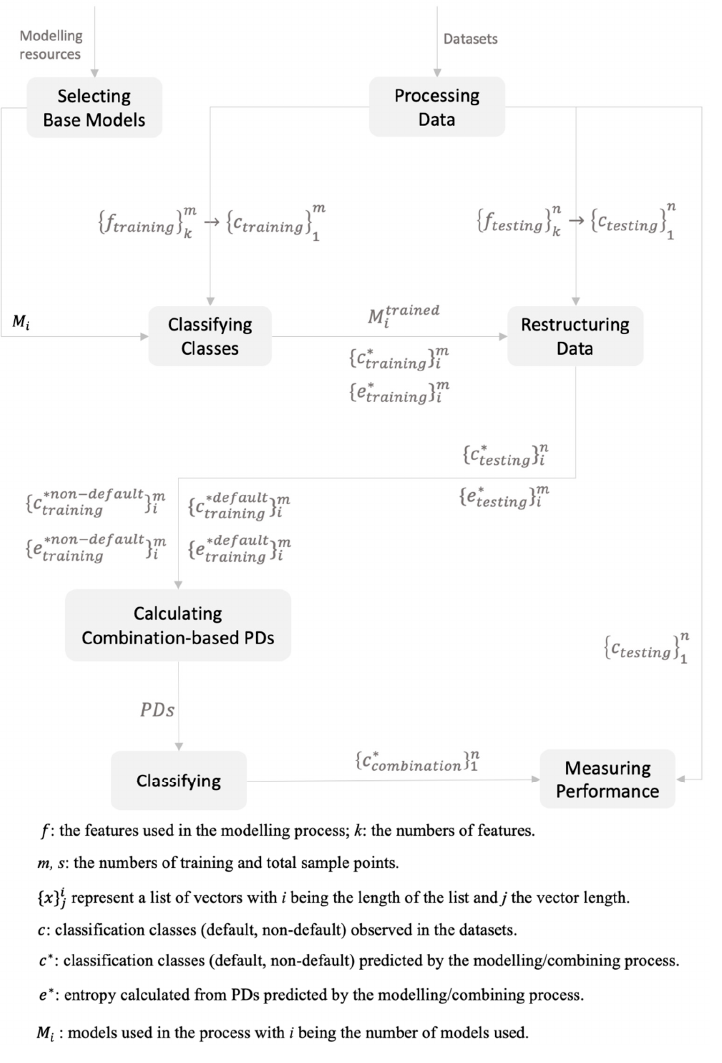
Figure A1. Flow Diagram of the Proposed Entropy-based Stacking Model.